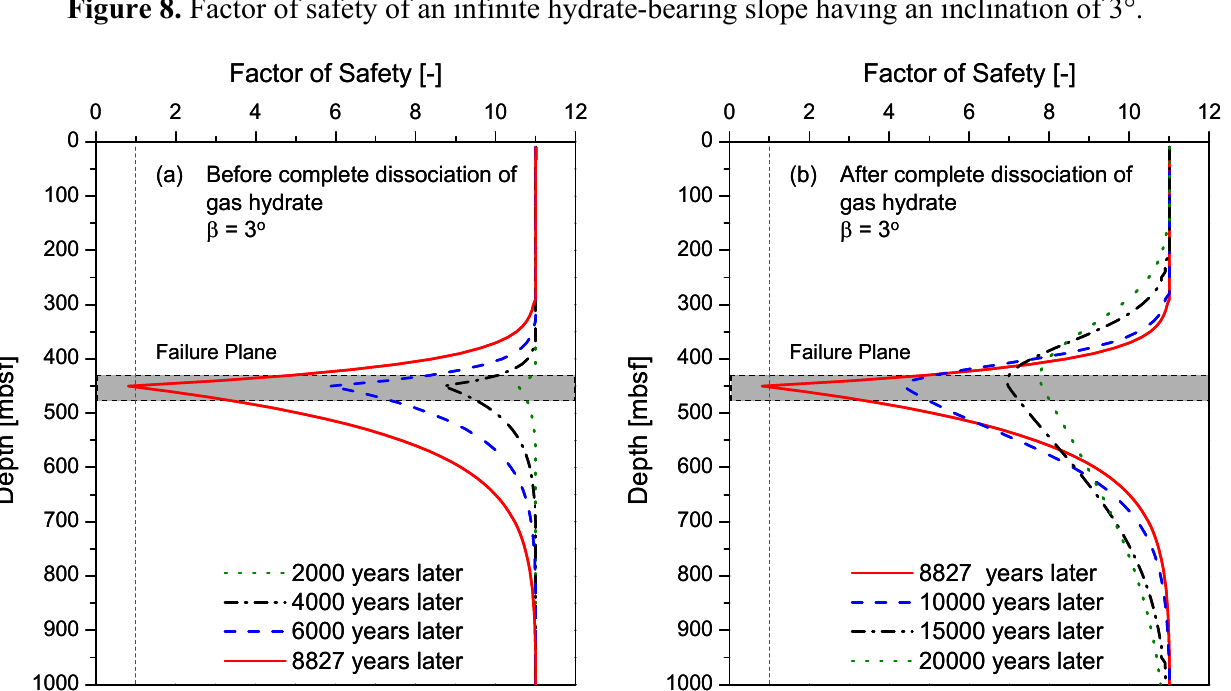
Figure 8. Factor of safety of an infinite hydrate-bearing slope having an inclination of 3°.